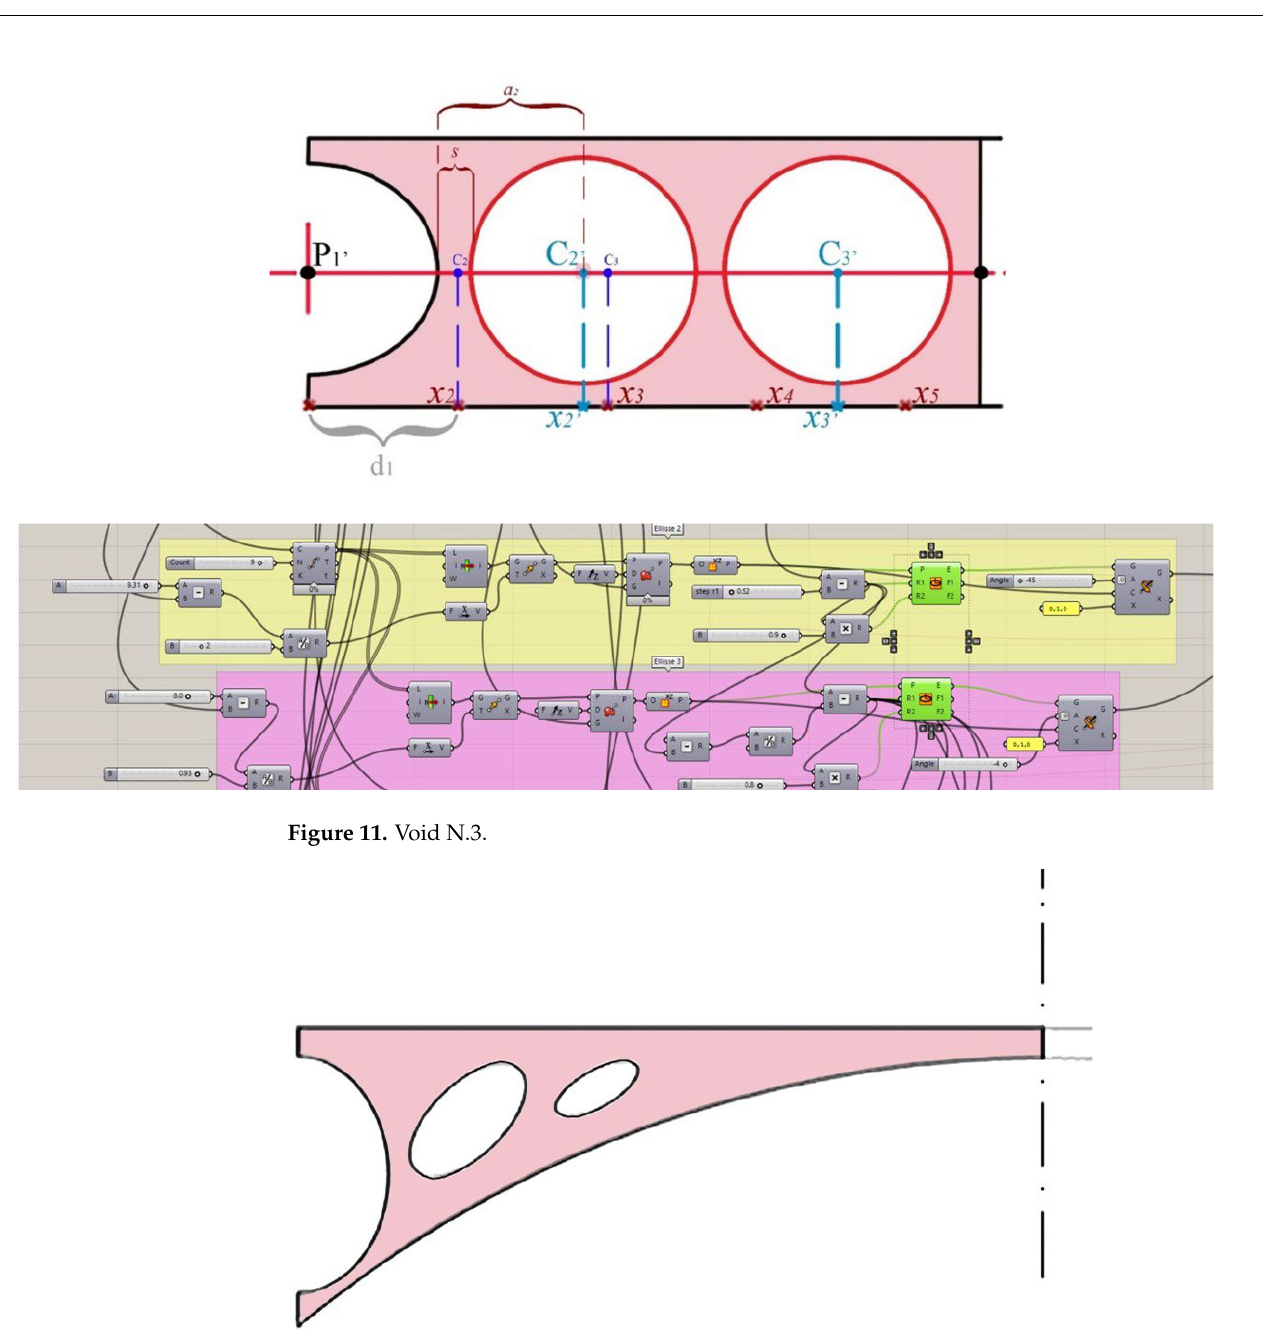
Figure 12. Rotated voids.